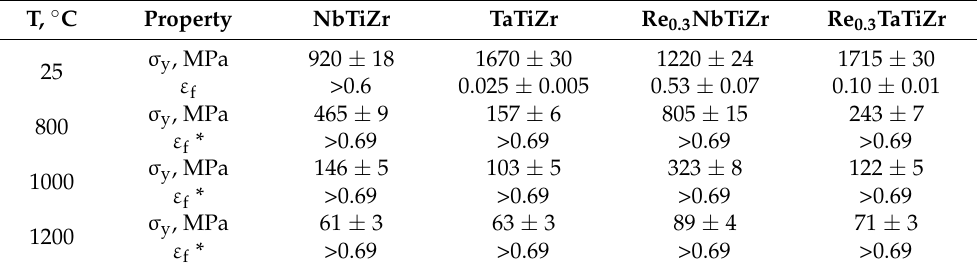
Table 3. Yield stress ( σ y ) and true fracture strain ( ε f ) of the studied alloys at different temperatures. T, °C